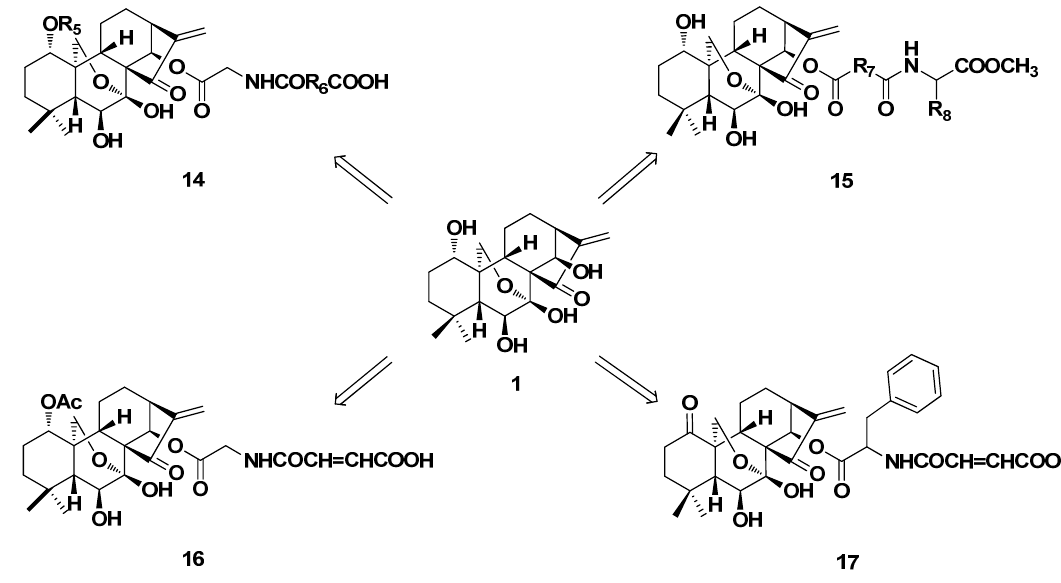
Figure 8. Synthesis of 1- O and 14- O -derivatives ( 14 – 17 ) of oridonin.